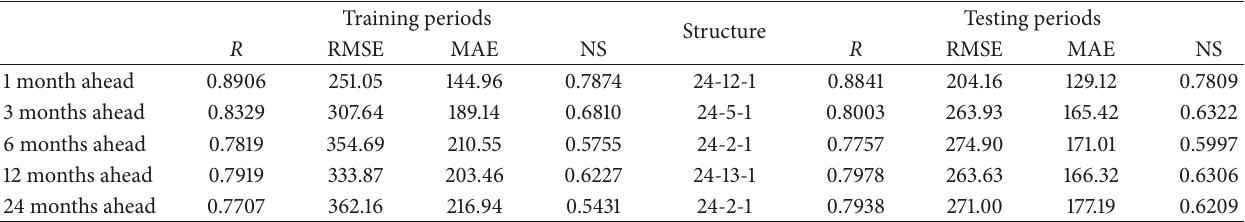
Table 9: Performance of the ANN model with two input variables (precipitation and air temperature) during the training and testing periods for 1-, 3-, 6-, 12-, and 24-month-ahead runoff forecasting in the YERHR.